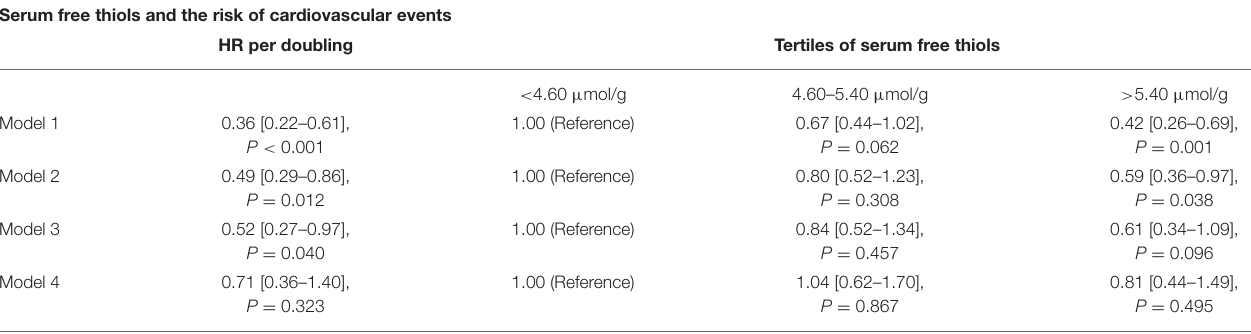
TABLE 4 | Cox proportional hazards regression analyses of the association between 2 log-transformed serum free thiols and the risk of CV events in the full female study population, with inclusion of potential confounding factors based on the directed acyclic graph (DAG). Serum free thiols and the risk of cardiovascular events HR per doubling Tertiles of serum free